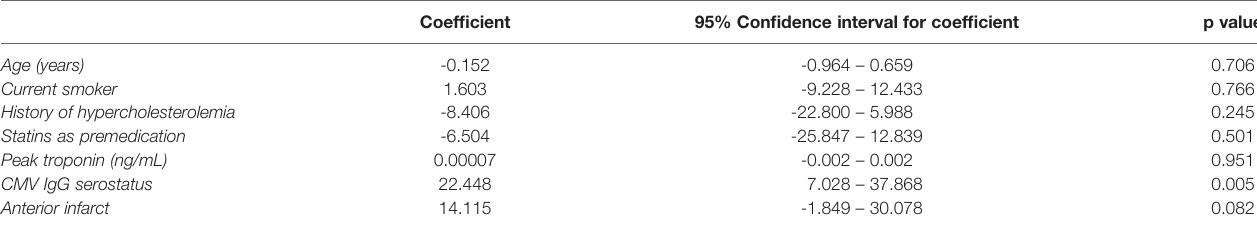
TABLE 2 | Full list of variables entered into multivariate linear regression model for change in end-diastolic volume over 12 weeks.